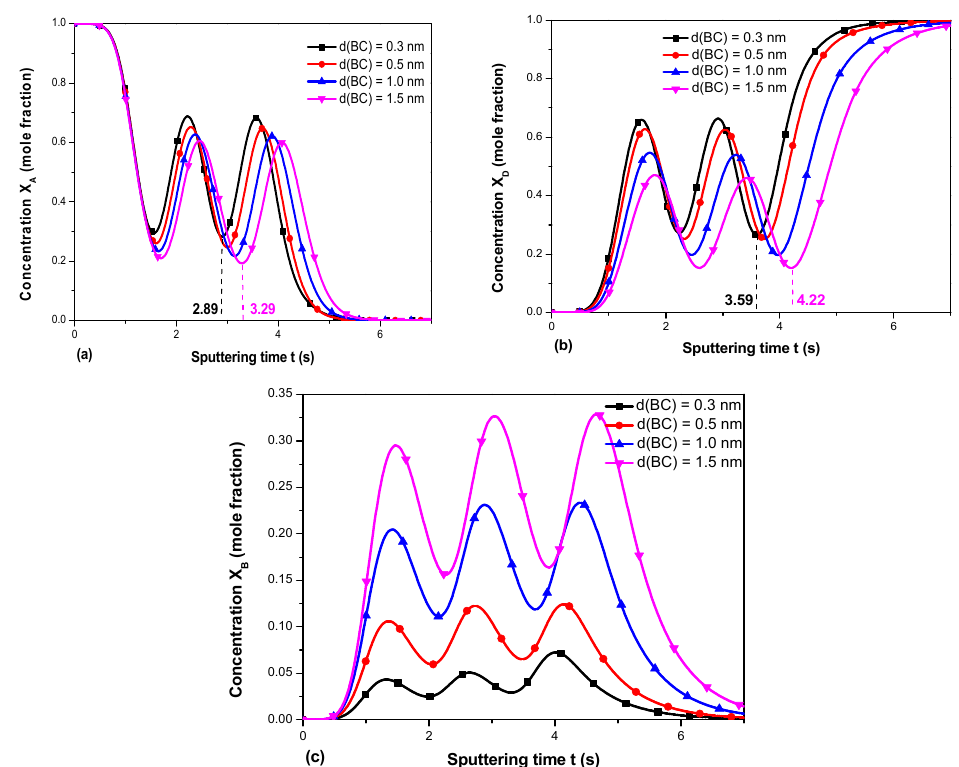
Coatings 2021 , 11 , x FOR PEER REVIEW Figure 2. Simulated time-concentration profiles of multilayer: ( a ) component A; ( b ) component D; and ( c ) component B, for different thickness values of delta layer and constant sputtering rates as indicated in the inset.